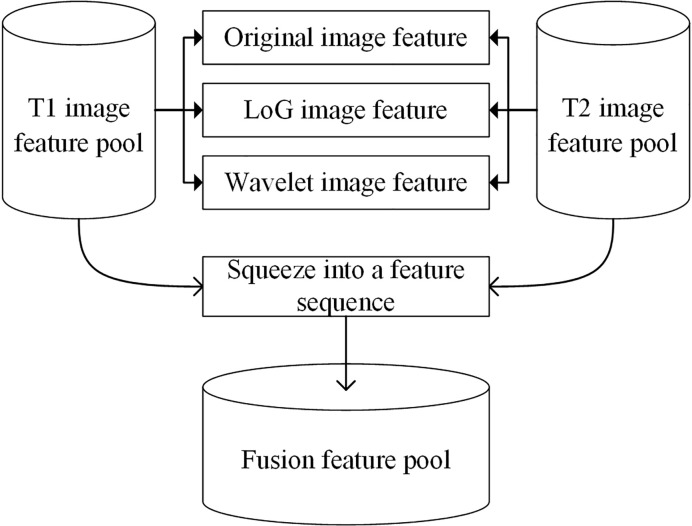
The workflow of the image feature fusion process.